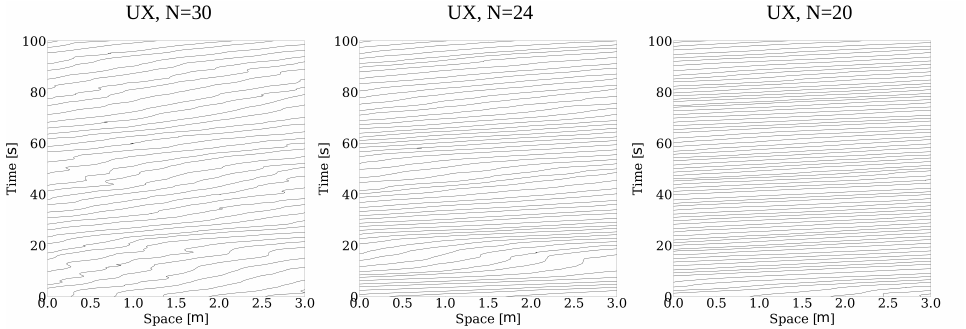
Figure 2. The trajectories over time for a sample of UX experiments.